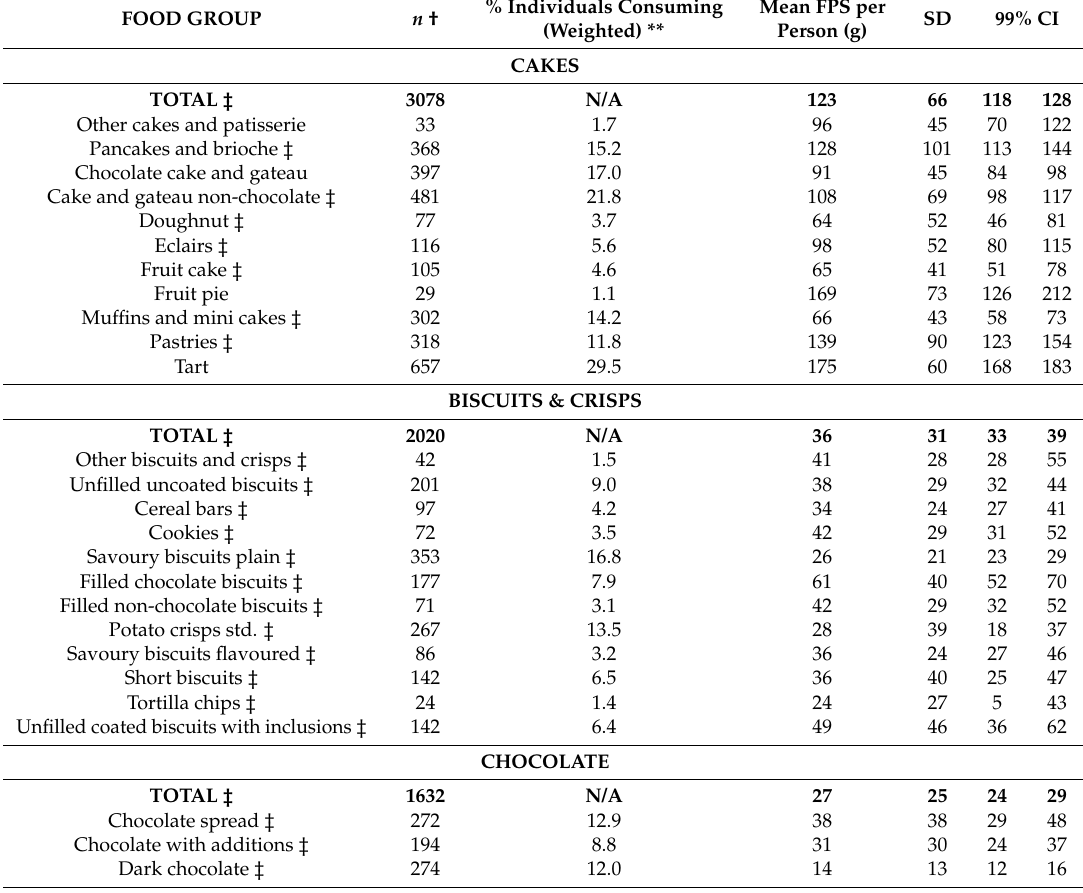
Table A1. Mean portion size of energy-dense foods for all consumers aged 19–64 years in the French INCA2. FOOD